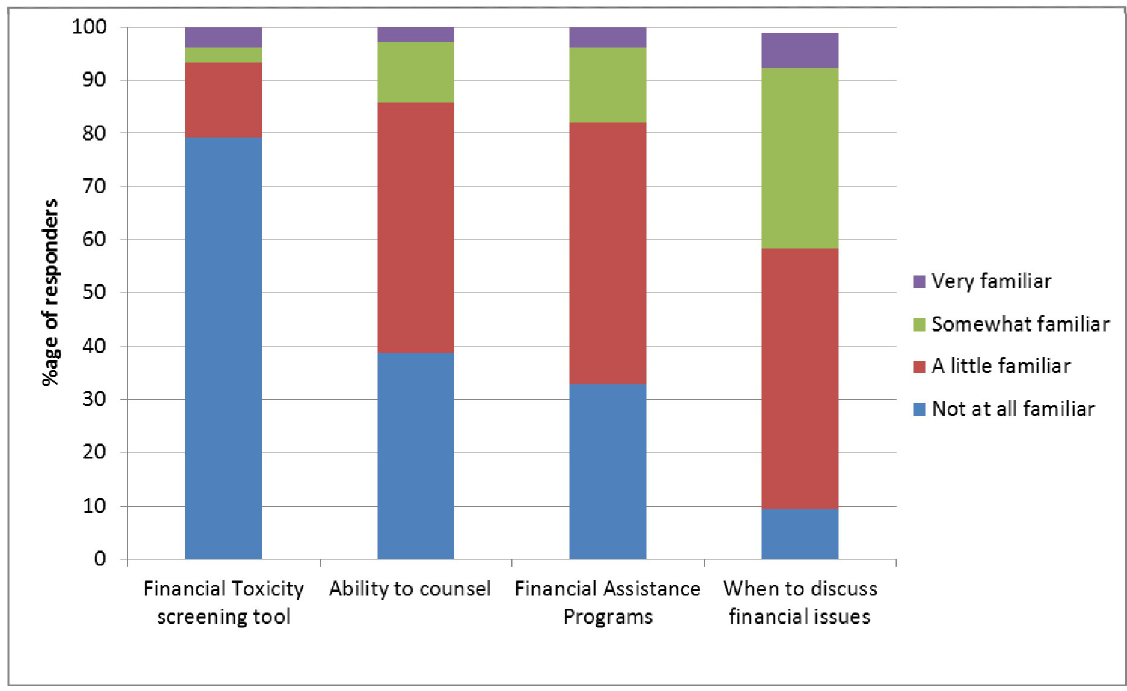
Fig 6. Oncologists’ familiarity with aspects of financial